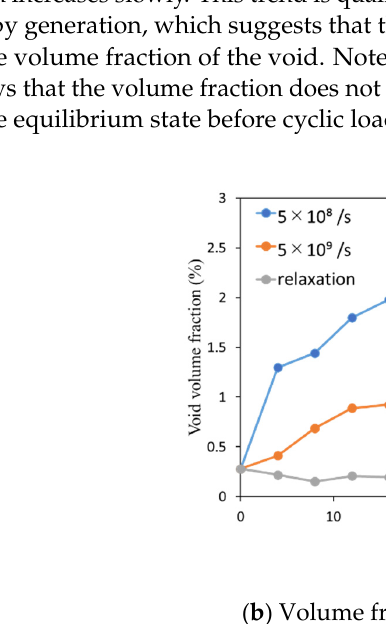
Figure 8. Time evolution of the number and the volume fraction of voids.